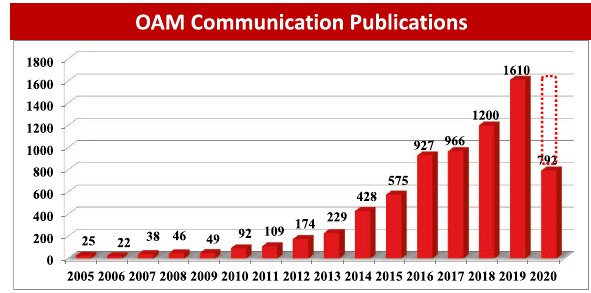
Figure 3: The orbital angular momentum (OAM)